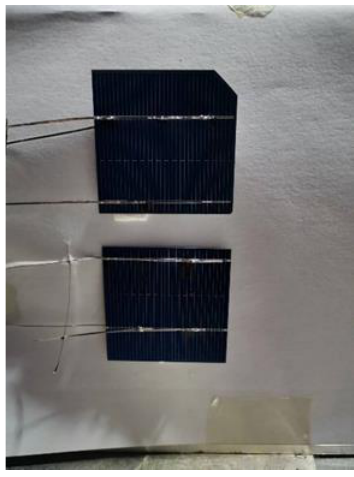
Figure 18. Photovoltaic cells observed (from top to bottom, the monocrystalline and polycrystalline silicon photovoltaic cell).